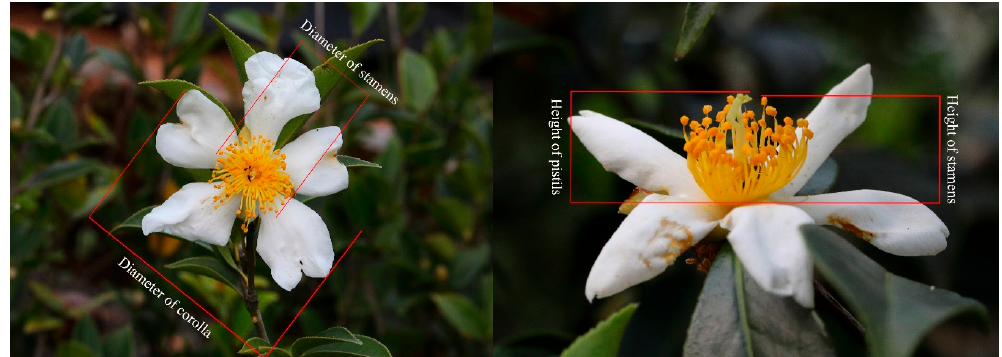
Figure 1. The measurement position for the diameter of the corolla and stamens and the height of stamens and pistils of Camellia ssp. flowers. stamens and pistils of Camellia ssp.